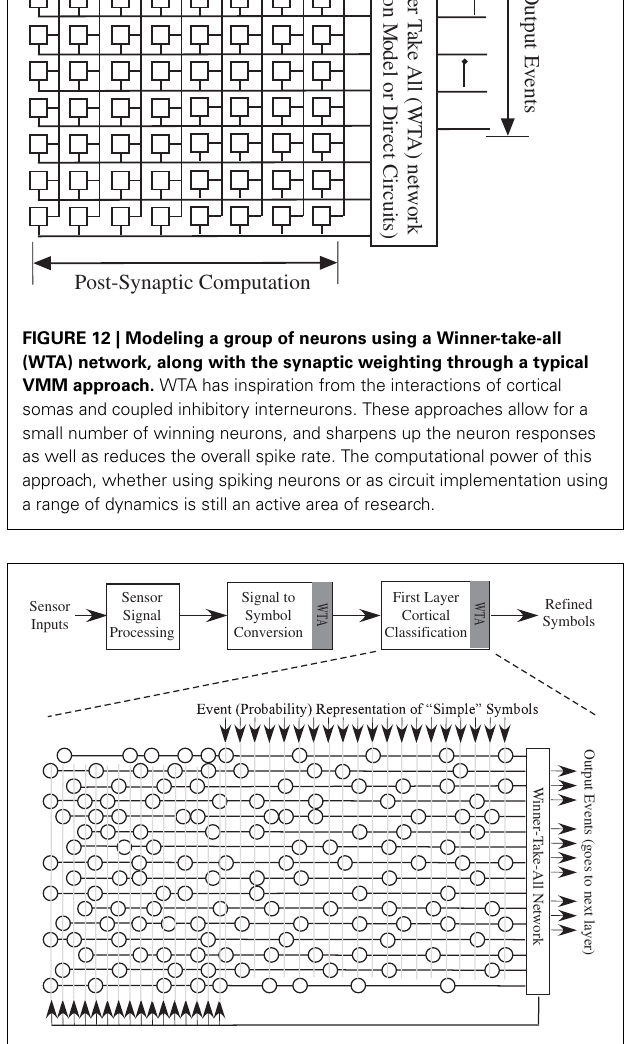
FIGURE 13 | Block diagram for computation through a number of neurons with dendritic structure; this structure comes from modeling of groups of cortical neurons. This approach is similar to wordspotting networks used for speech recognition systems. The inputs come from another event generation layer, whether a layer of cortical neurons or as part an initial transform from sensor inputs to symbol event representation. Linear dendritic lines are being assumed in this figure, although both biological neurons and Si implementations utilize a multi-branching